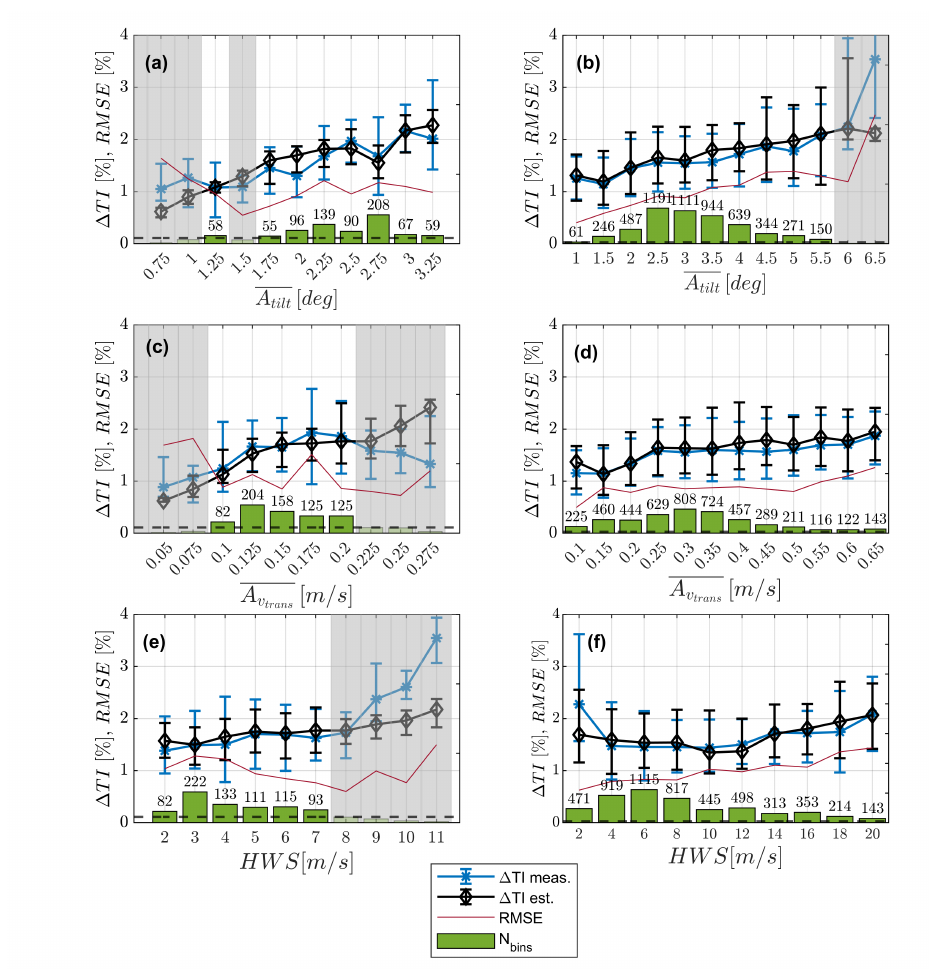
Figure 9. Validation of the analytical-error formulation: Global statistics for the PdP campaign (6 to 30 June 2013) and IJmuiden campaign (1 April to 1 June 2015). The left panels show the results obtained for the PdP campaign, and the right panels show the results obtained for the IJmuiden campaign, with the comparison between the measured and the estimated TI increment as a function of different motion conditions clustered by (panels ( a , b )) mean tilt amplitude (rotational motion), (panels ( c , d )) mean translational-velocity amplitude , and (panels ( e , f )) mean HWS . The error bars indicate the 25th and 75th percentiles. The bar graphs represent the number of occurrences in the data for each category of bin. The solid red lines represent the RMSE between ∆ TI est and ∆ TI meas for each category of bin. The bins containing less than 5% of the PdP population are gray